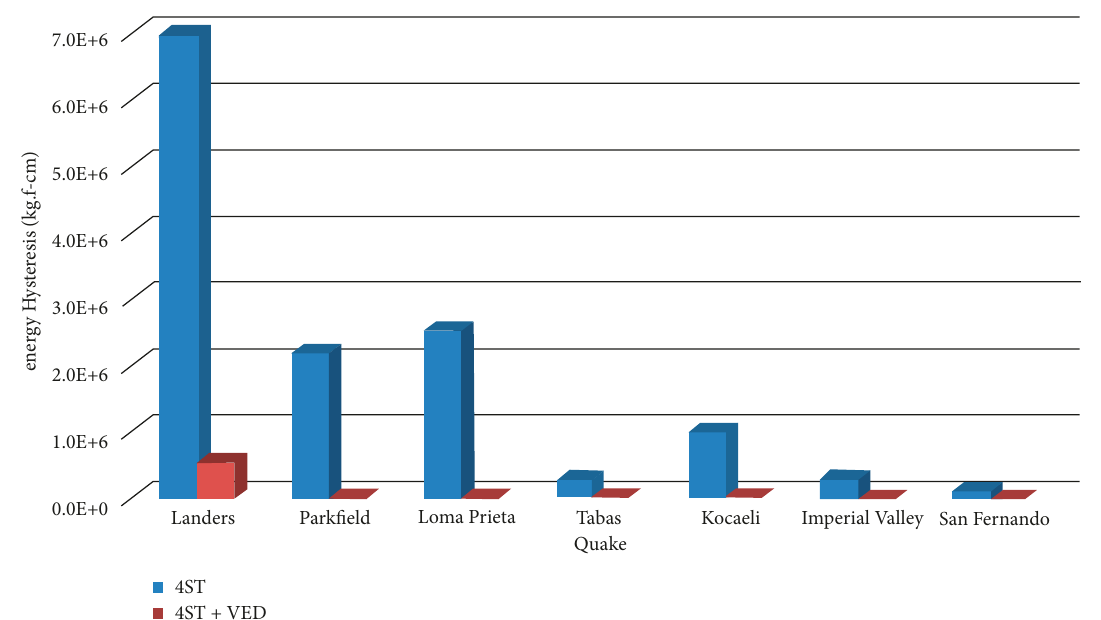
Figure 9: Hysteresis energy applied to a 4-story frame under near-field records in two modes, with and without structure reduces the level of hysteresis energy. The results earthquake was calculated. In Figures 9 and 10, the results from the hysteresis energyapplied to the 4-story frame, under fromthehysteresisenergyofallframeswereshownseparately the far and near-field earthquakes with and without dampers, for the records before and after the damper is added to the are presented in Figure 9. classes. As seen from the diagrams, adding a damper to the